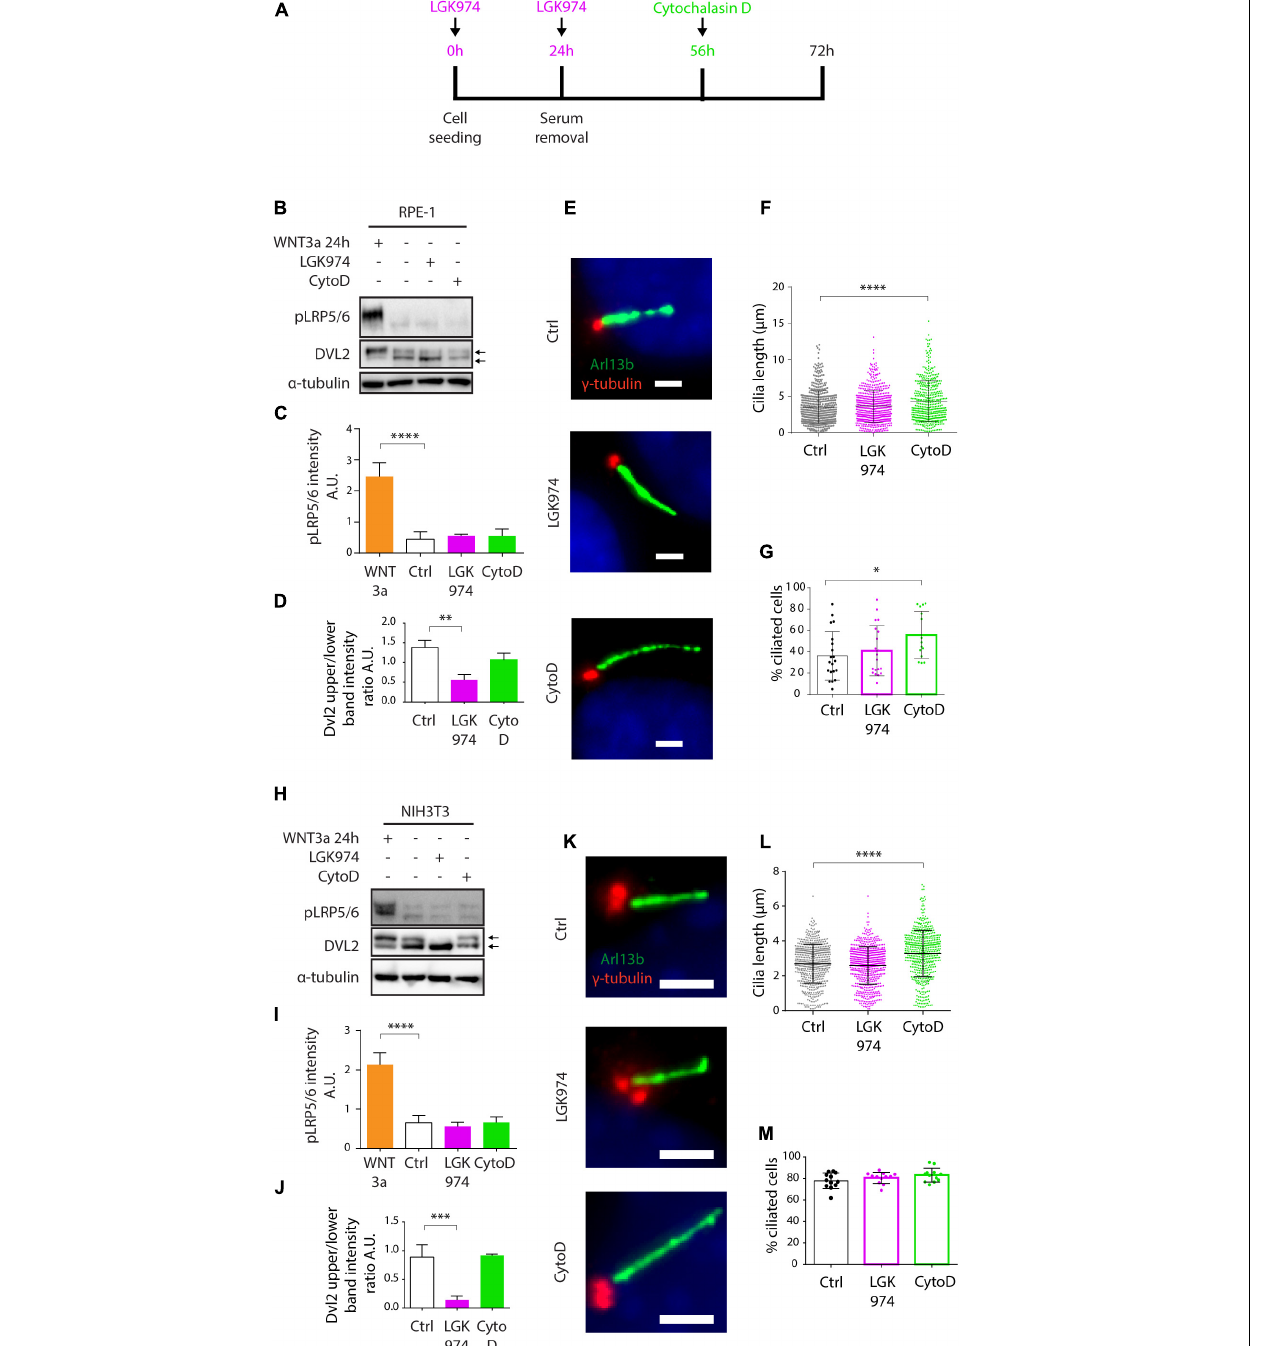
Frontiers in Cell and Developmental Biology |